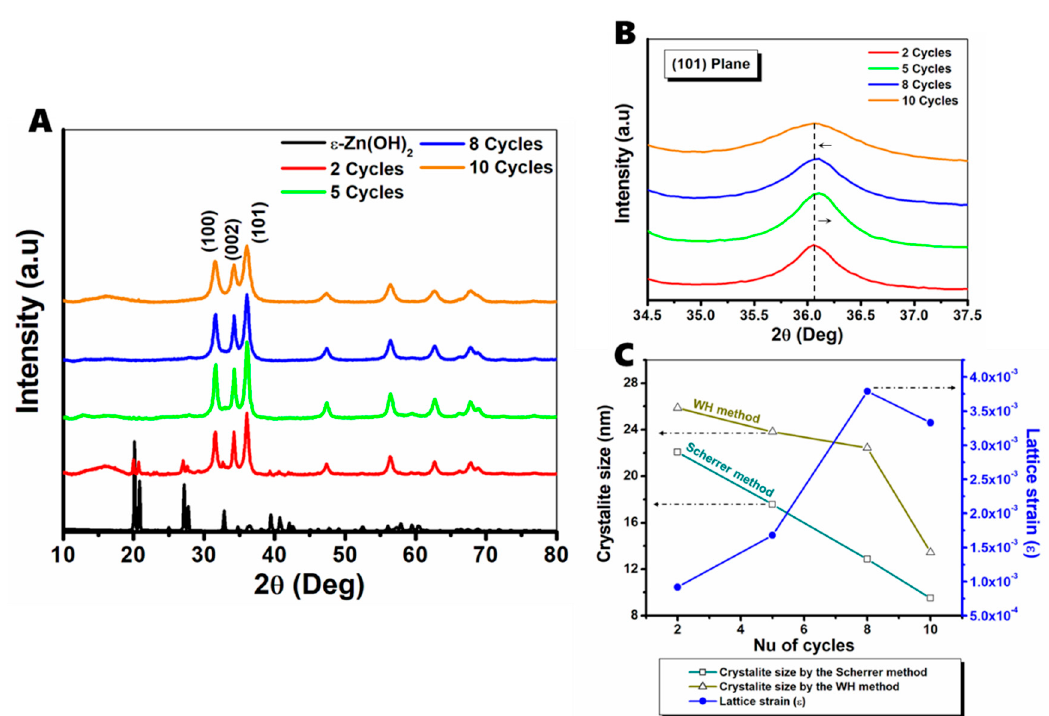
Figure 1. Powder diffraction patterns of zinc oxides: ( A ) XRD spectra of ε -Zn(OH) 2 (before milling) and milled products with different cycles; (1,0,0), (0,0,2), and (1,0,1) characteristic ZnO peaks are indicated. ( B ) Peak broadening and shifting of the (1,0,1) characteristic peak of ZnO. ( C ) Comparison of crystallite size calculated by the Scherrer and Williamson–Hall (WH) methods and lattice strain.